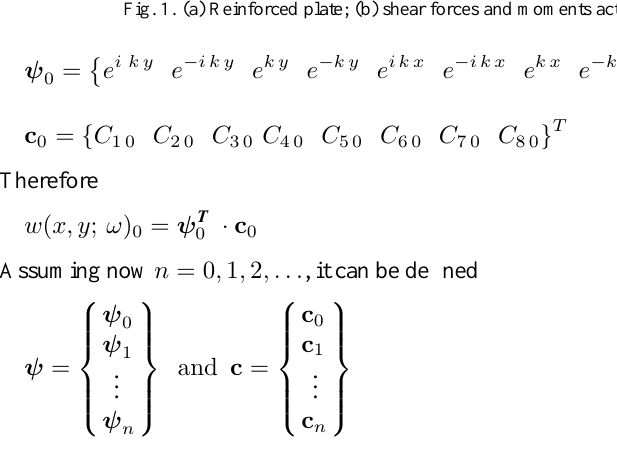
Fig. 1. (a) Reinforced plate; (b) shear forces and moments acting on the plate and on the reinforcing